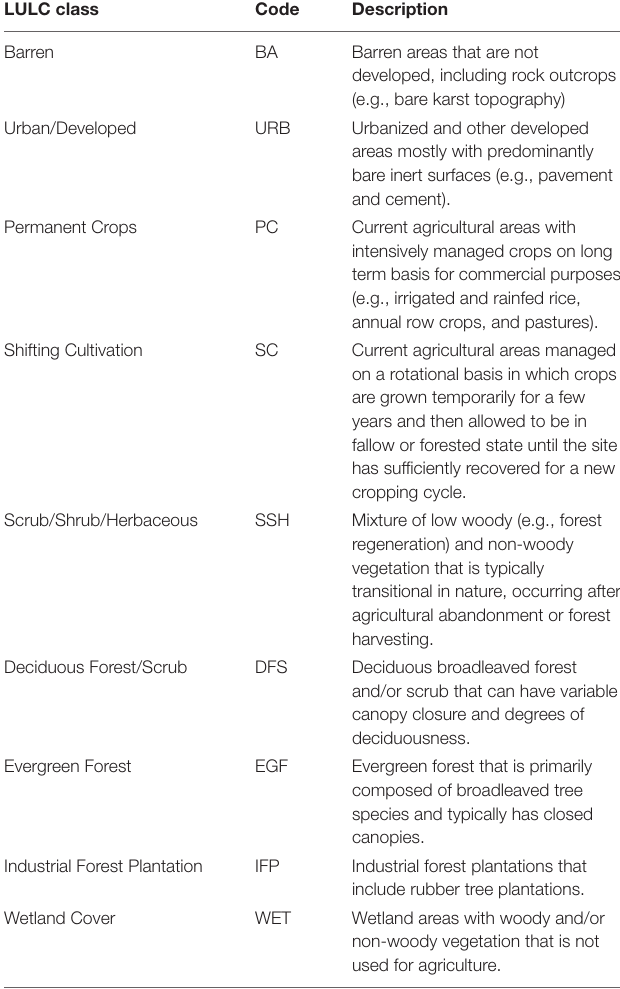
TABLE 1 | Description of LULC classes used to generate change